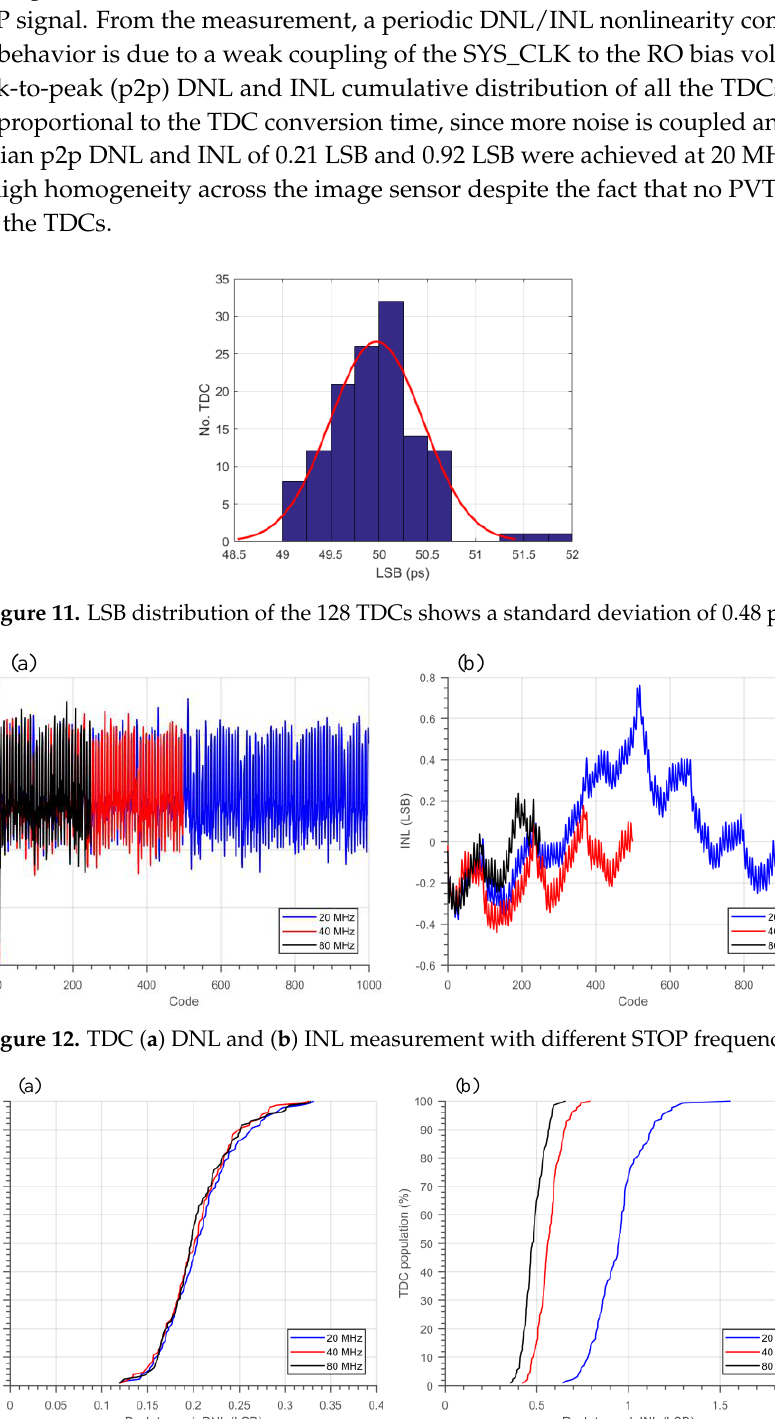
Figure 13. Peak-to-peak ( a ) DNL and ( b ) INL cumulative distribution with different STOP frequency.